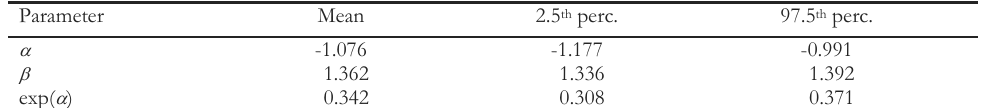
Posterior summaries for the calibration